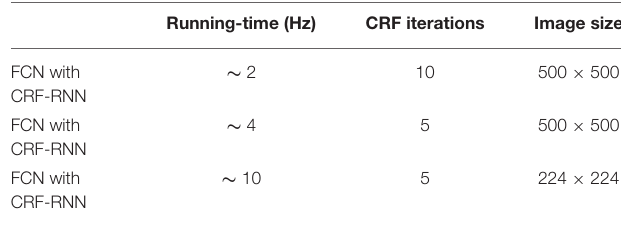
TABLE 7 | The running-time performance of the proposed